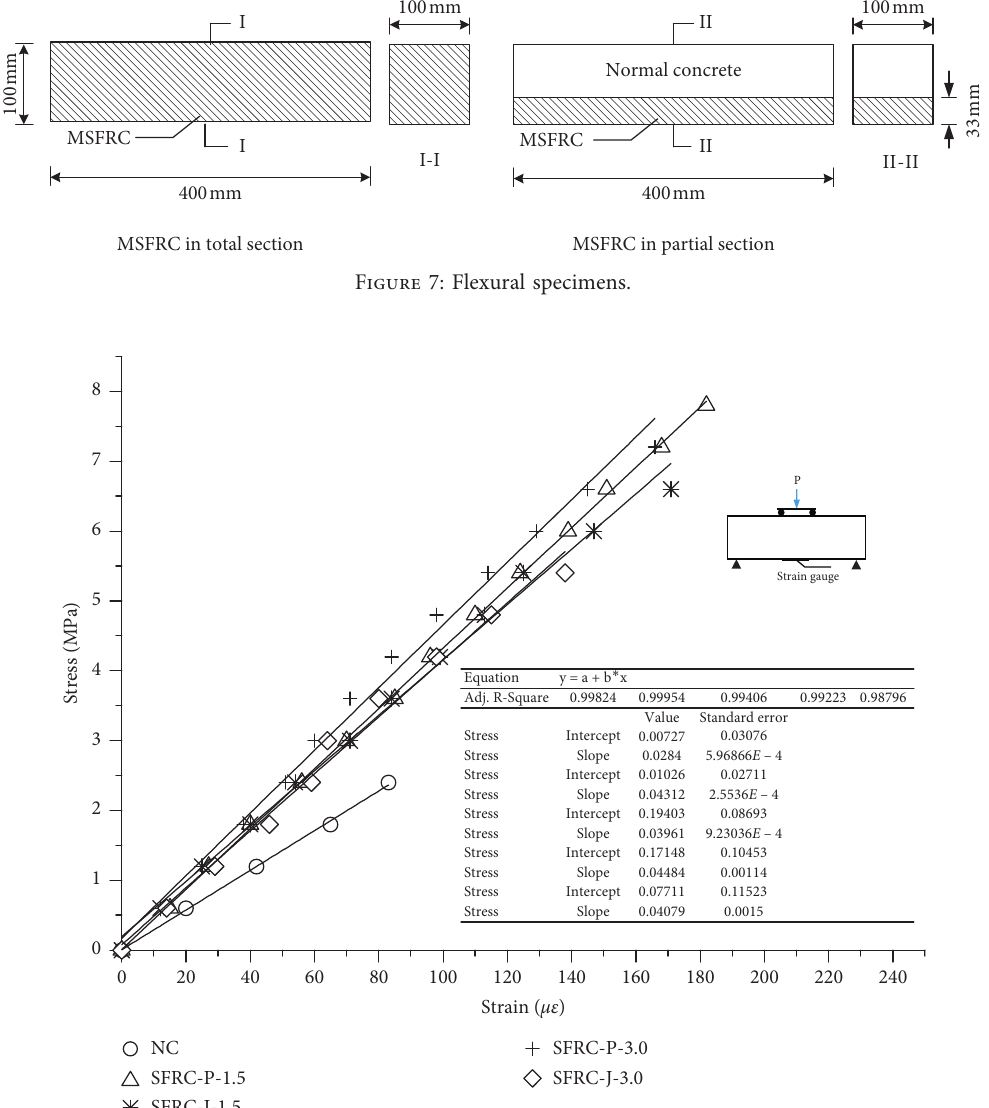
Figure 8: Plot of stress-strain curves.